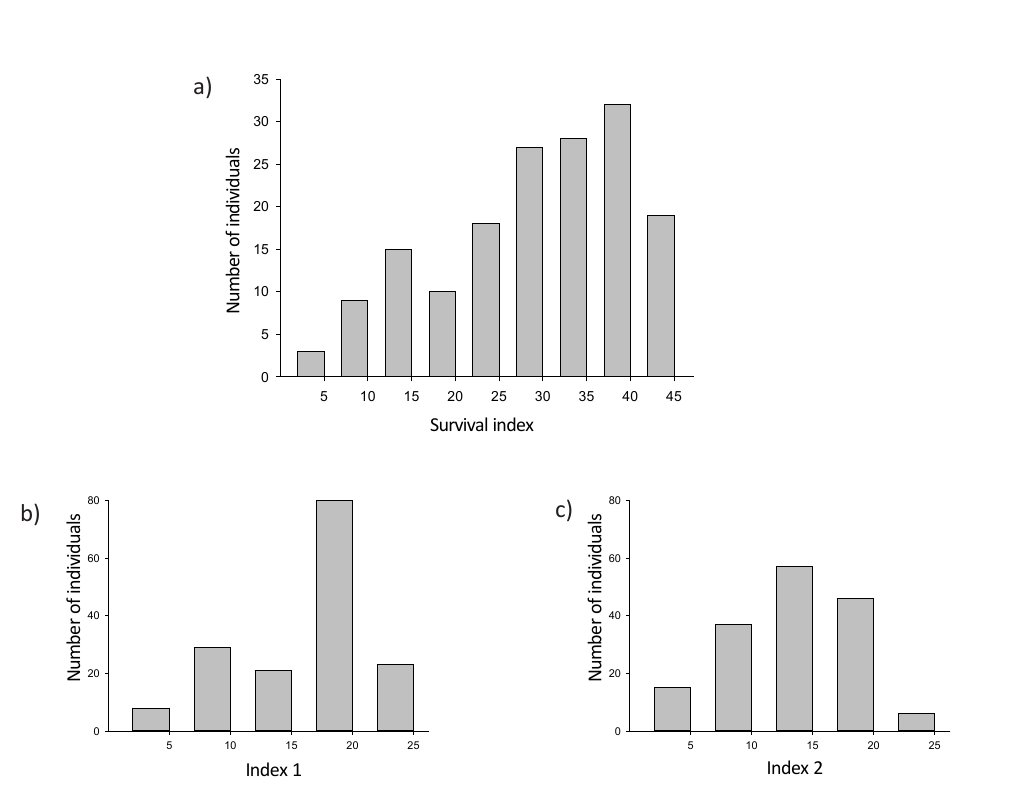
Fig.1. Frequency distribution of survival index (a), which describes Typhula resistance (2 meaning totally resistant), in the F progeny of the timothy cross Tammisto II x Nosappu. Resistance tests were made on 6–10 1 clones of each F individual. The survival index is the sum of two different indices: b) index 1, which describes 1 plant survival, and c) index 2, which describes the ability of plants to recover from the